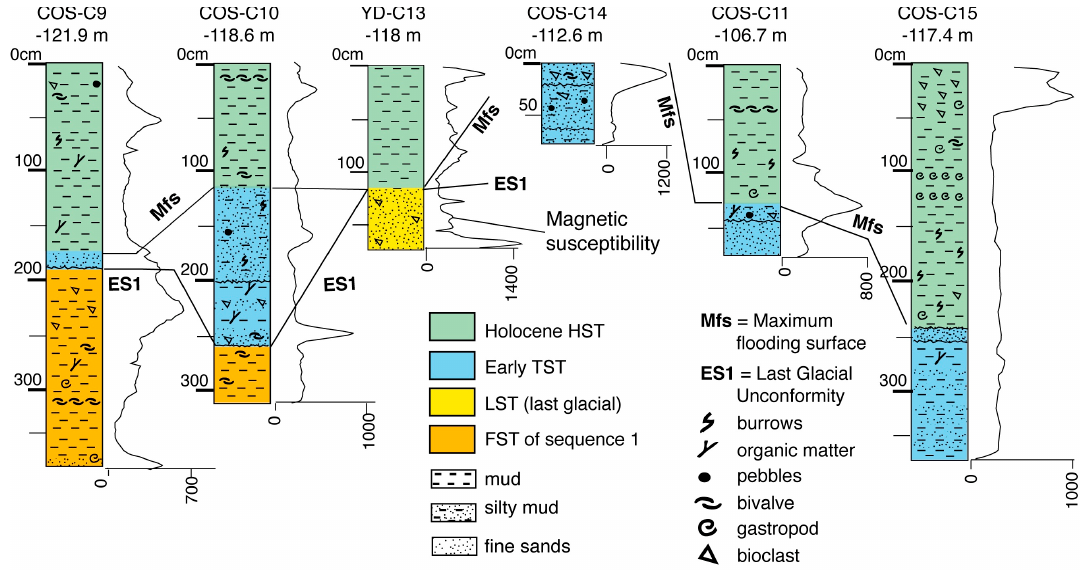
Figure 7. Lithologic composition of short sediment cores that reached the TSR on the South Adriatic shelf (location in Figures 1 and 6; description and details in Section 4.3). Magnetic susceptibility was used to crosscheck identification and correlation of key stratigraphic surfaces. Systems tracts definition is based on seismic-stratigraphic analysis and calibration with chronostratigraphic data (see Section 3).